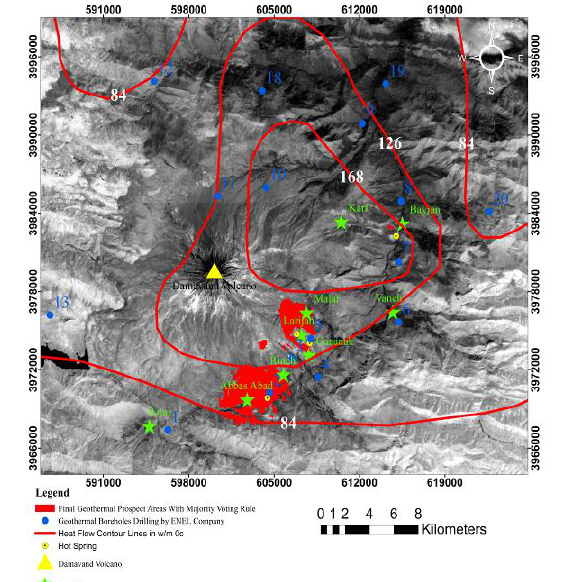
Figure 10. Comparison of final potential regions with thermal flux from the drilling.